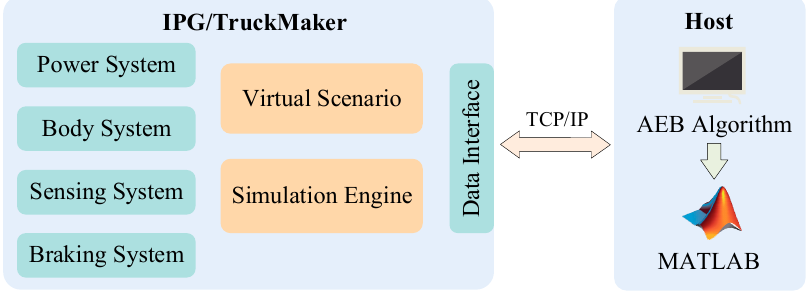
Figure 6. SIL testing method.